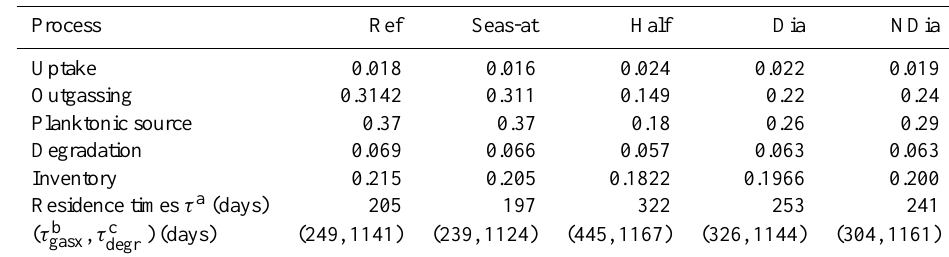
Table 2. Simulated global annual bromoform production and loss (GmolCHBr 3 yr − 1 ), inventory (GmolCHBr 3 ), and residence time (days); the first number refers to gas exchange and the second number to degradation